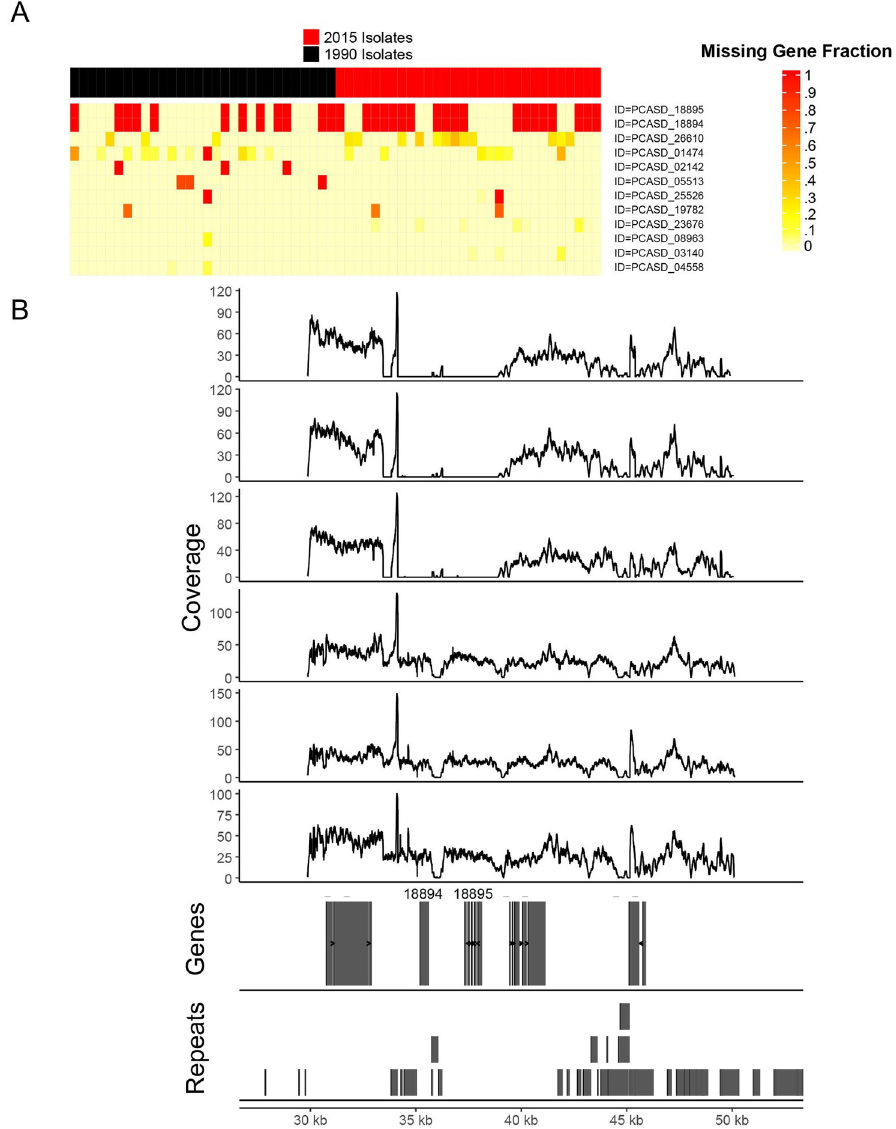
Fig 6. Detection of gene deletions in haustorially-expressed predicted effector repertoires in 1990 and 2015. (A) Presence/absence variation in 12 haustorially-expressed predicted effectors in 1990 and 2015. All isolates are represented as a black (1990) and red (2015) top bar (x-axis) above missing gene fraction matrix (y-axis). The heatmap indicates the missing fraction of each gene model as assessed with read mapping coverage. Color scale indicates 0 = 0% deletion to 1 = 100% deletion. (B) A detailed view of read coverage across the genomic region surrounding PCASD_18894/18895. The top six tracks show mapping coverage in the surrounding region from 3 representative isolates with (top) and without (bottom) the deletion. The bottom two tracks show gene and repeat locations,